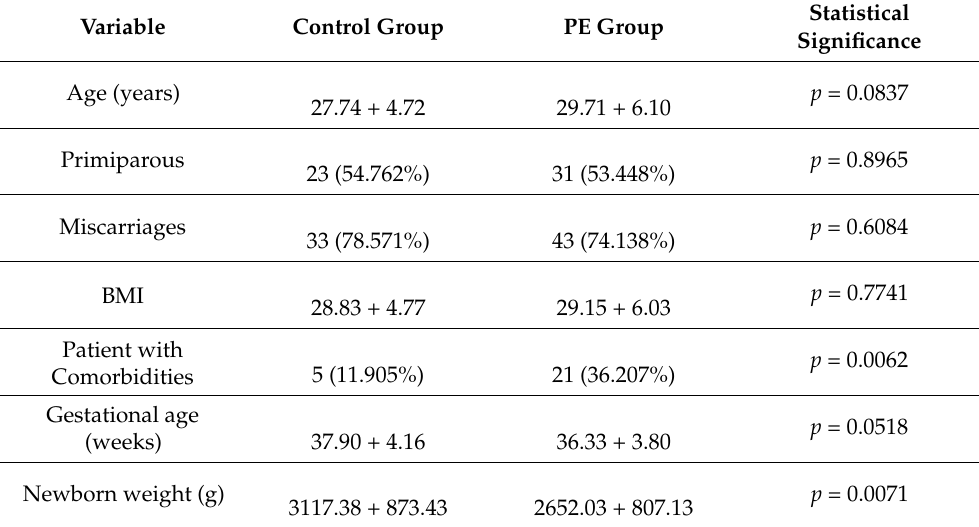
Table 1. Patient